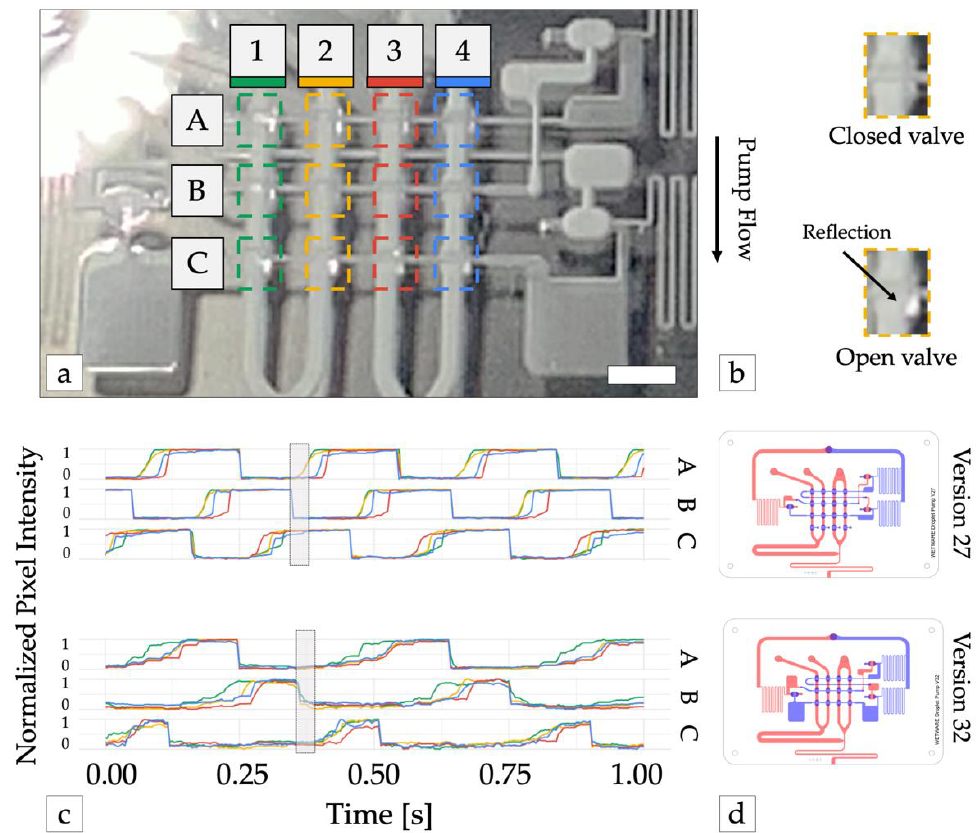
Figure 3. Optimizing pump waveform synthesis. ( a ) Pump operation was monitored with high-speed video. The reflection of incident light from the membrane of each pump valve was used to detect valve state (open or closed). Dashed colored lines show the area of the image analyzed for each valve. Scale bar = 3 mm. ( b ) Valve detail shows open valves reflect more light back the camera. ( c ) Time traces of normalized reflected light from each valve from device versions 27 (top) and version 32 (bottom). 1 = valve open (vacuum pressure), 0 = valve closed (atmospheric pressure). Adding large capacitors before and after each row of pump valves (version 32) increased the time required to open each row of valves and the subsequent inverter gate, preventing all pump stages (A, B, and C) from being open simultaneously (shaded rectangle), which resulted in improved pump performance. ( d ) Illustrations of device versions 27 and 32. Channels in the top and bottom layers are shown in blue and red, respectively.